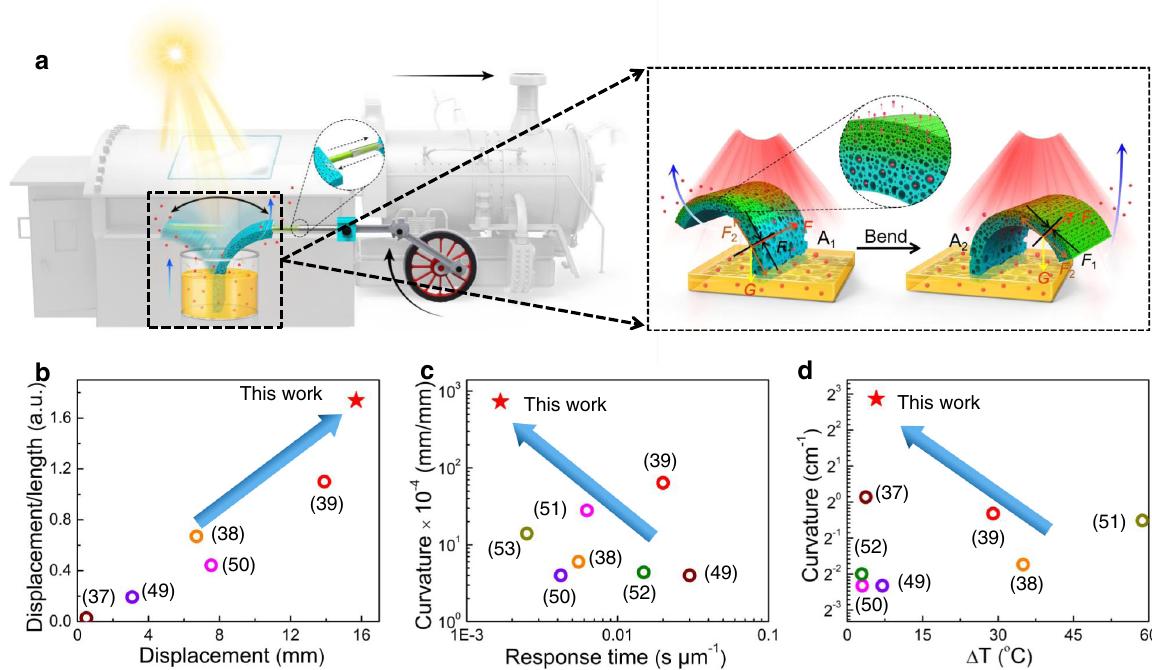
Fig. 1 | Oscillating Light Engine of the PP/CB actuator. a Schematic diagram of fi lmasalightmotor(theenlargedimageisaschematicillustrationoftheoscillating bending actuation and mechanical analysis). b Comparison of the displacement and displacement/length ratio with those ofoscillating actuators. c Comparisonof